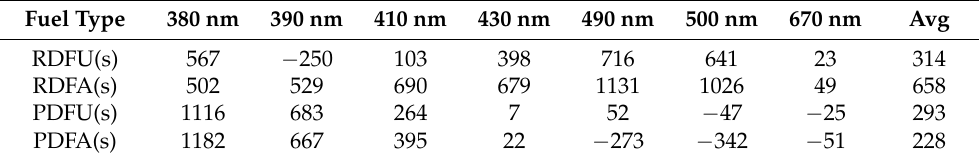
Table 6. Signals shifts S(360s)–S(1800s) of the modulated part of degradation DHE:UVonTon